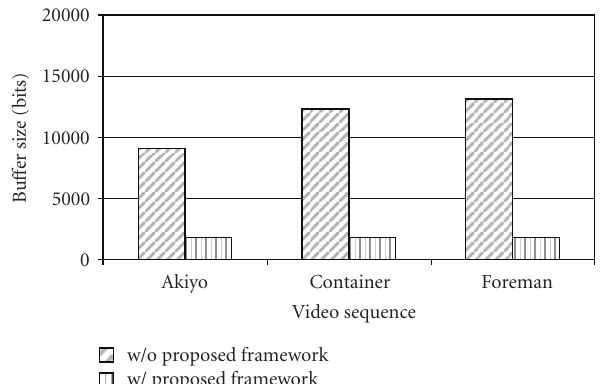
Figure 6: Comparison of the application layer bu ff er sizes for three test video sequences under moderate channel condition ( μ = 10 − 2 ).